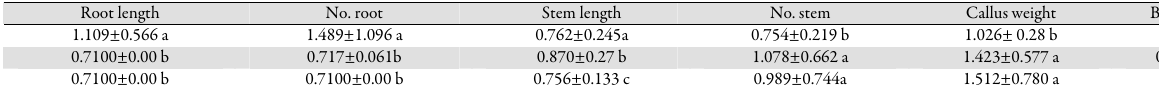
Table 3. The effect of BAP on callus weight, shoot and root induction Root length